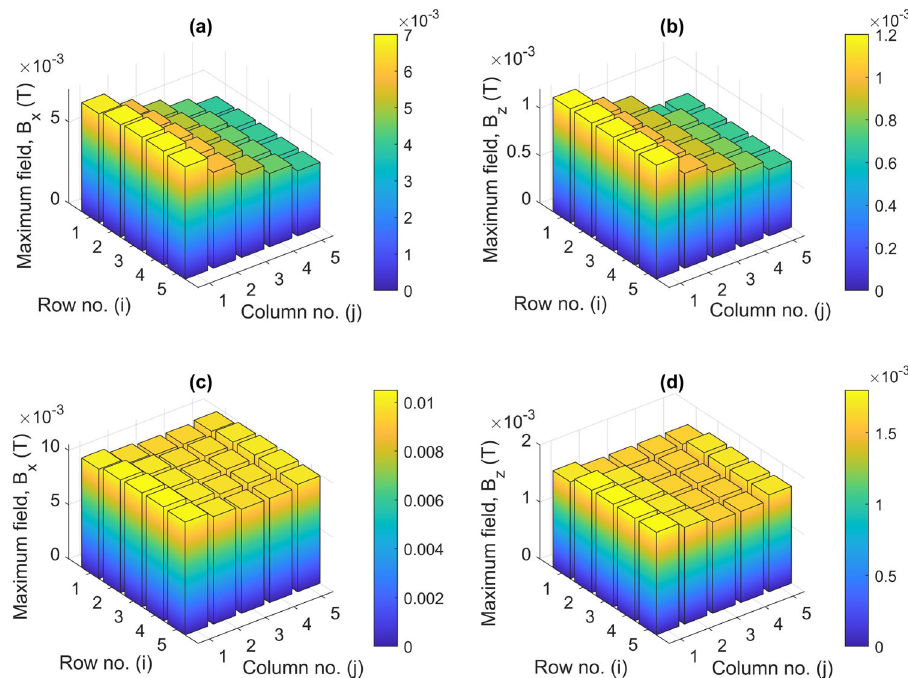
Fig. 2 Histogram of induced magnetic fi eld along x - and z -axes in the qubit volume. a Maximum magnetic fi eld of each spin along x ( B x ), and b along z ( B z ), induced by a single nanomagnet. c Maximum magnetic fi eld of each spin along x ( B x ), and d along z ( B z ), induced in the dual nanomagnet setup. The color map indicates low (blue) and high (yellow) induced fi